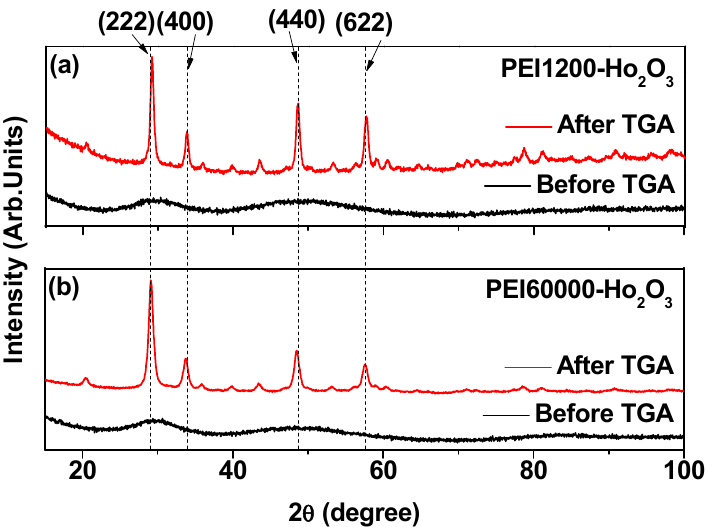
Figure 4. XRD patterns before (i.e., as-prepared) and after TGA of ( a ) PEI1200- and ( b ) PEI60000- coated ultrasmall Ho 2 O 3 nanoparticles. The (222), (400), (440), and (622) assignments on the XRD peaks after TGA are the (hkl) Miller indices of cubic Ho 2 O 3 . All peaks after TGA are assigned with the (hkl) Miller indices of cubic Ho 2 O 3 .